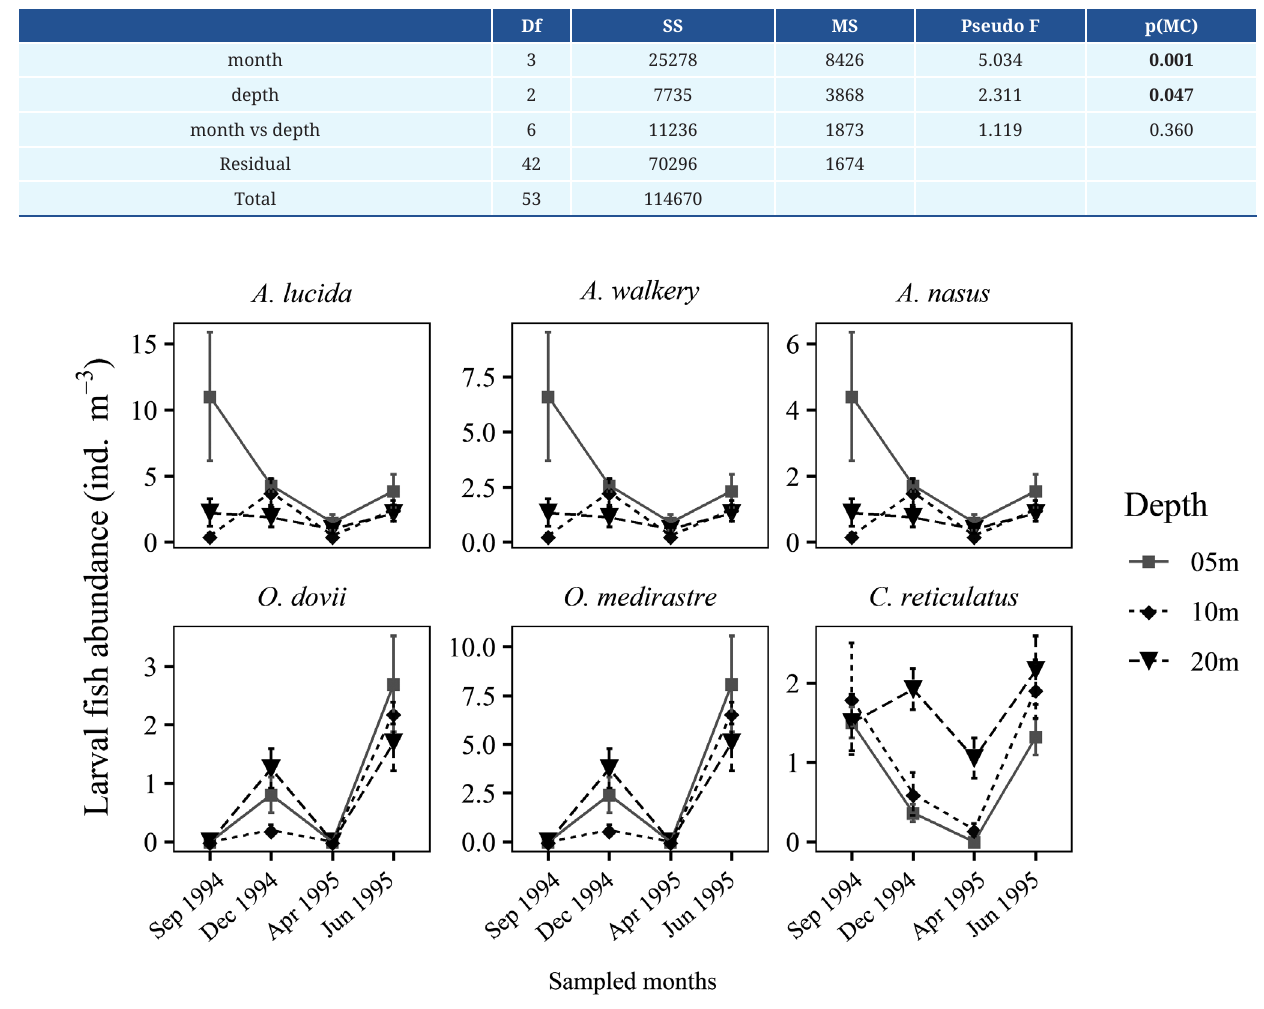
FIGURE 6 | Temporal and vertical variations of the abundance of the most abundant species found in the study. Dots indicate the mean value and error bars the Standard Error. SEP: September, DEC: December, Apr: April, JUN: